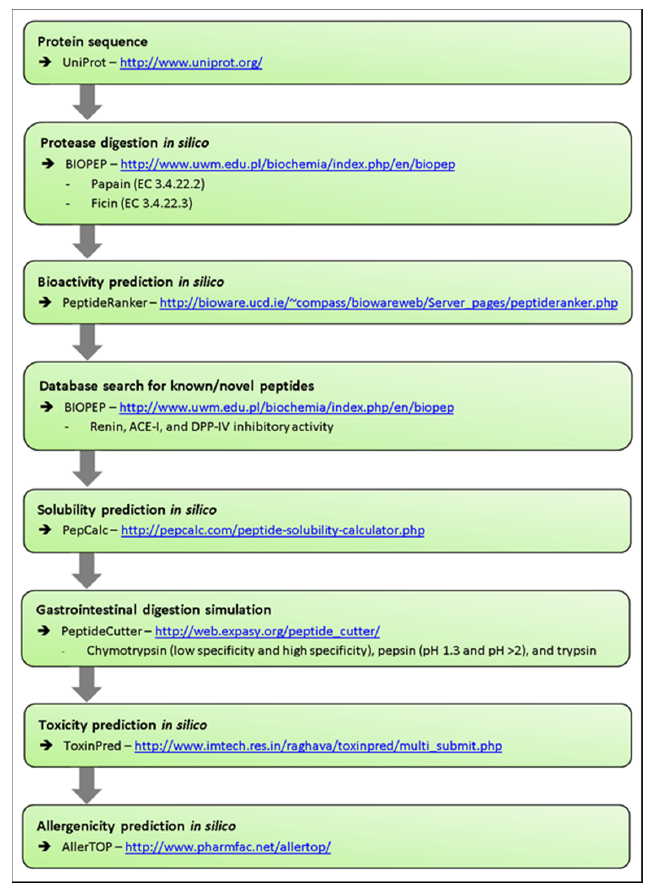
Figure 1. Methodology for in silico digestion and bioactivity prediction of oat protein hydrolysates.